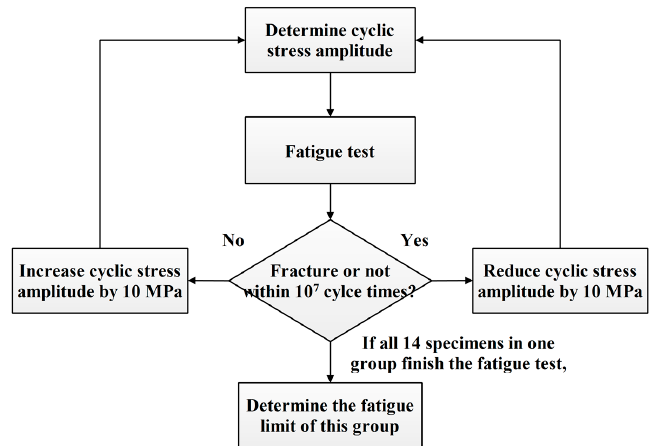
Figure 7. Procedure of the up and down method.